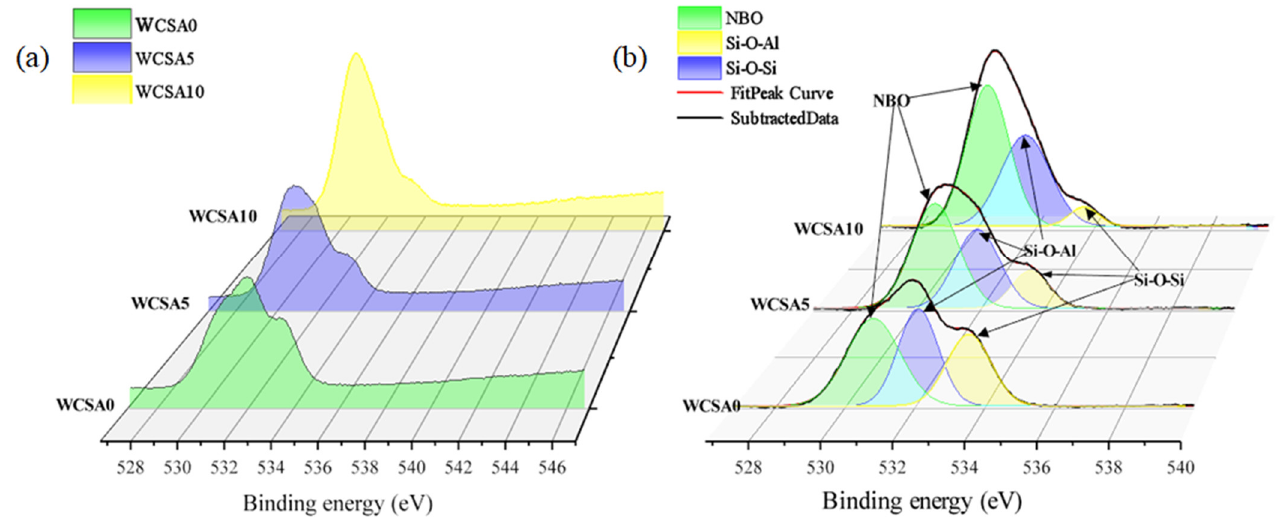
Figure 8. O1s spectra for WCS: WCSA0, WCSA5, and WCSA10; ( a ) original spectra and ( b ) decon- volved peaks. Table 5. Peak center (C), FWHM, and relative area (A) from the curve fitting of O1s.